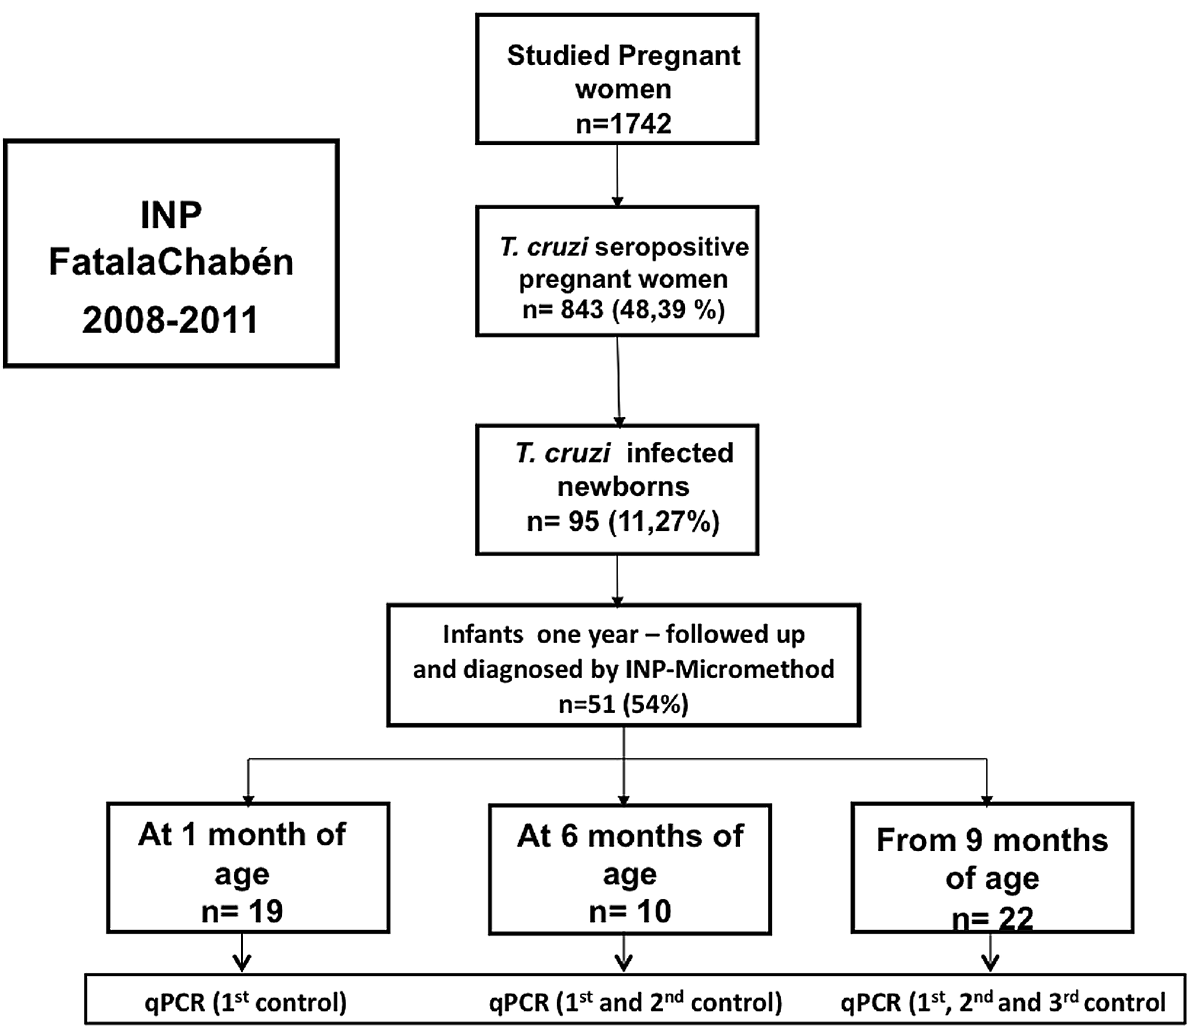
Figure 1. Flow diagram chart of the serological and parasitological studies in pregnant women and their infected children. T. cruzi quantitative DNA amplification was retrospectively performed in three groups of congenitally infected children.